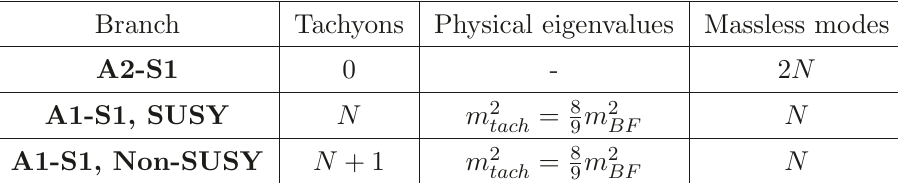
Table 2 . Massless and tachyonic modes for the extrema in the branch S1 . Here N stands for the number of complex structure moduli. The extra zero modes in the branch A2-S1 are discussed